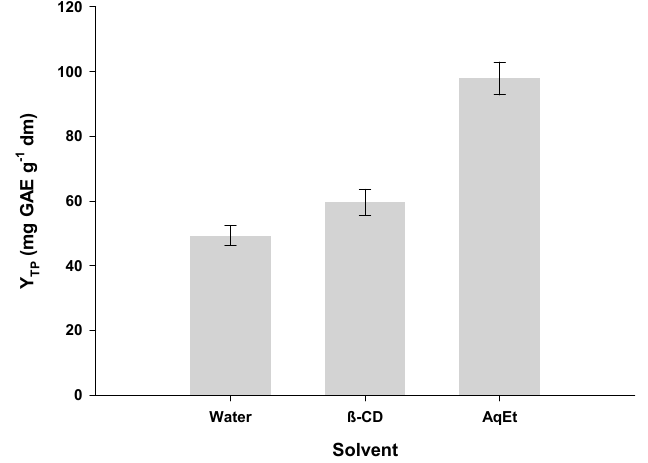
Figure 6. Bar plot displaying Y TP of the extraction media tested. Extractions with β -CD were performed under optimized conditions ( C CD = 1.5%, t us = 30 min, R L/S = 90 mL g − 1 ), under stirring at 900 rpm, for 180 min. The same conditions (except for the addition of β -CD) were applied to the extractions with water and 60% aqueous ethanol (AqEt).